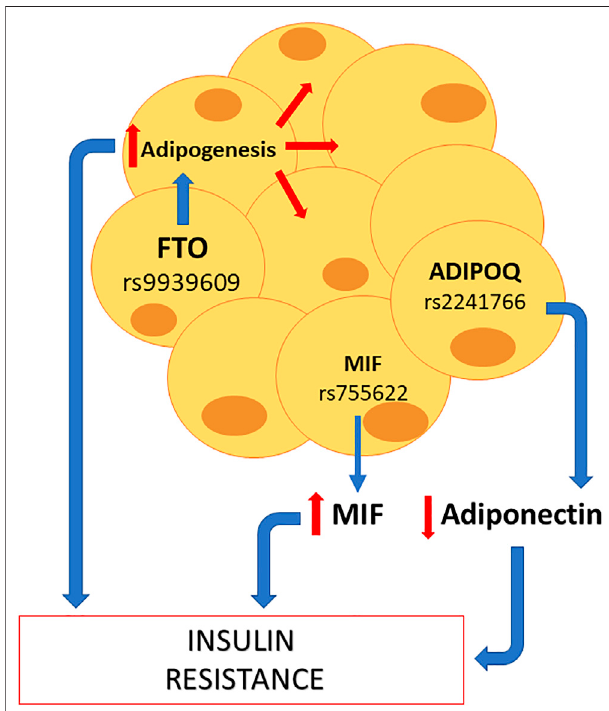
FIGURE 3 | Potential SNPs capable of promoting maternal insulin resistance at adipose level. Some SNPs that can affect the adipocyte function are FTO rs9939609, which increases adipogenesis; MIF rs755622, which increases MIF levels; and ADIPOQ rs2241766, which reduces adiponectin levels. All these three effects favor the appearance of insulin resistance, and subsequently, gestational diabetes